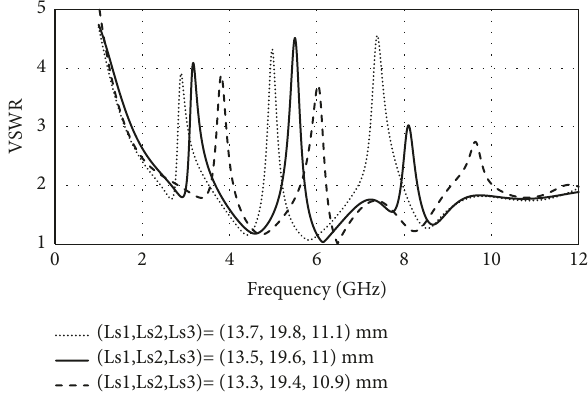
Figure 5: Simulated VSWR by varying the diameter of the radiating patch.